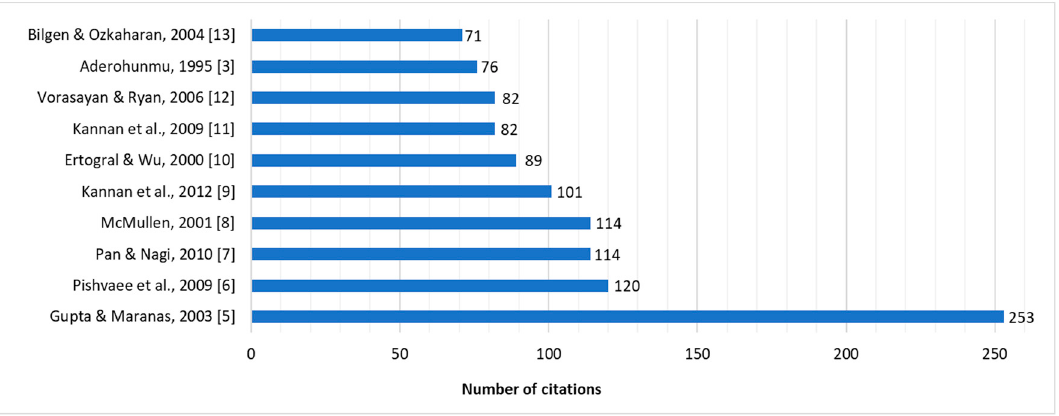
Figure 3. The ten most cited articles based on a search in Web of Science [3,5–13].